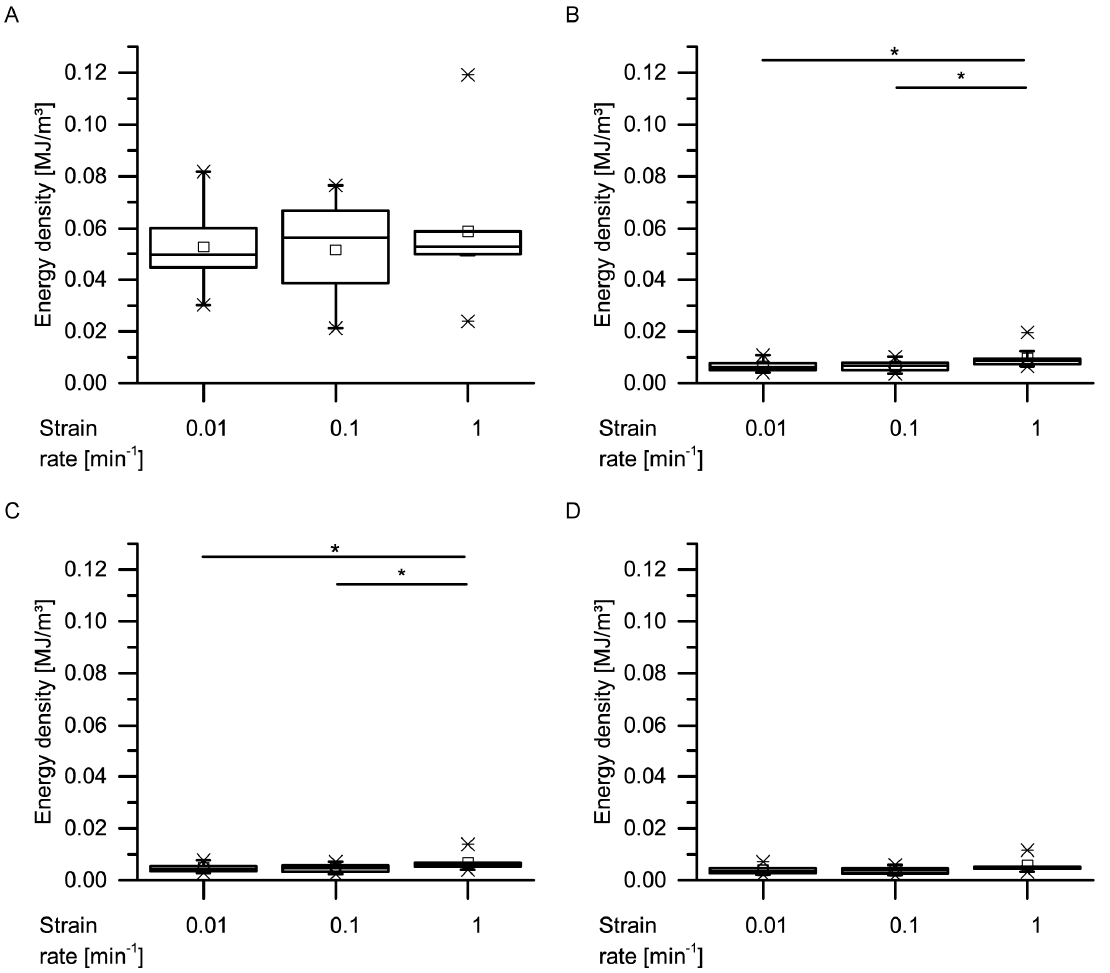
Figure 13. Energy densities of one whole cycle (dissipated energy E d ) of the quasistatic cyclic compression tests with unchanged maximum compression, for the first ( A ), second ( B ), third ( C ) and fourth ( D ) cycles (statistical test: Kruskal–Wallis test; n = 10 for each group). Significant differences are marked by asterisks, with the levels of significance indicated as follows: * p < 0.05.